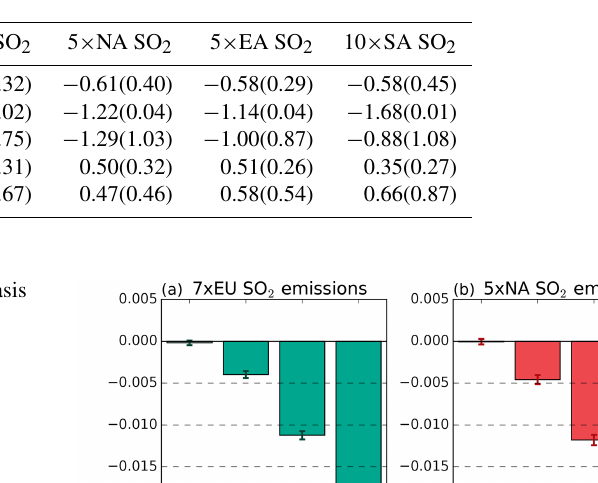
Table 2. Global results from the experiment where SO 2 emissions in different regions are changed. Units are 10 − 2 K(TgSyr − 1 ) − 1 for temperature change per emission change, 10 − 2 Wm − 2 (TgSyr − 1 ) − 1 for RF and ERF per emission change and K(Wm − 2 ) − 1 for temperature change per unit RF and ERF. Standard deviations are in parentheses.